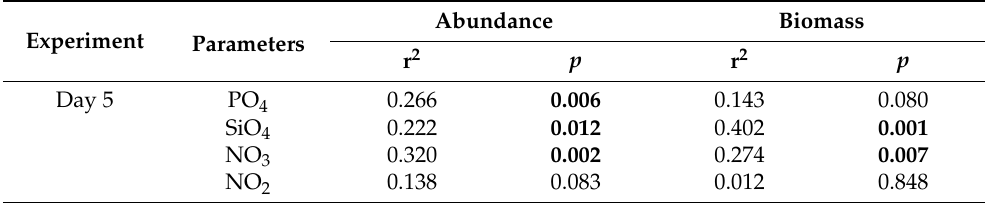
Figure 7. NMDS ordinations of microplankton and significant environmental correlates of Day 5 taxa abundances ( left ) and biomasses ( right ) for final control and final nutrient ‐ amended samples. Final control samples are hollow and final nutrient ‐ amended samples are filled. Abundance stress = 0.095. Biomass stress = 0.190. Table 4. Spearman correlation values (r 2 ) and permutation-based p -values between explanatory variables and microplankton assemblage square-root taxa abundances and log(x + 1) biomasses from Day 5 Final Treatments from all nutrient-amendment experiments. Statistically significant p -values are in